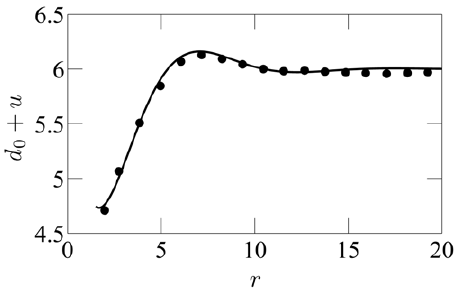
Figure 3. Thickness deformation due to a mismatched inclusion. Membrane thickness profile from Ref. [16] in the vicinity of a mismatched inclusion with hydrophobic thickness ‘ ^ 2 : 4nm and radius r 0 ~ 9A , with center in r ~ 0 , as a function of the radial coordinate r . The equilibrium membrane hydrophobic thickness is d 0 ^ 3 : 6nm . The unit of length on the graph is 6 A˚, as in Ref. [16]. Dots: numerical data (the error bars on the data, not reproduced here, are about 1 A˚ wide [16]). Line: best fit. Exactly as in the original reference, the numerical data is fitted to Eqs. 46–53 with k ’ a ~ 0 , taking u 0 and the (renormalized) spontaneous curvature ~ cc 0 as fitting parameters, the other constants being known from the fluctuation spectra.